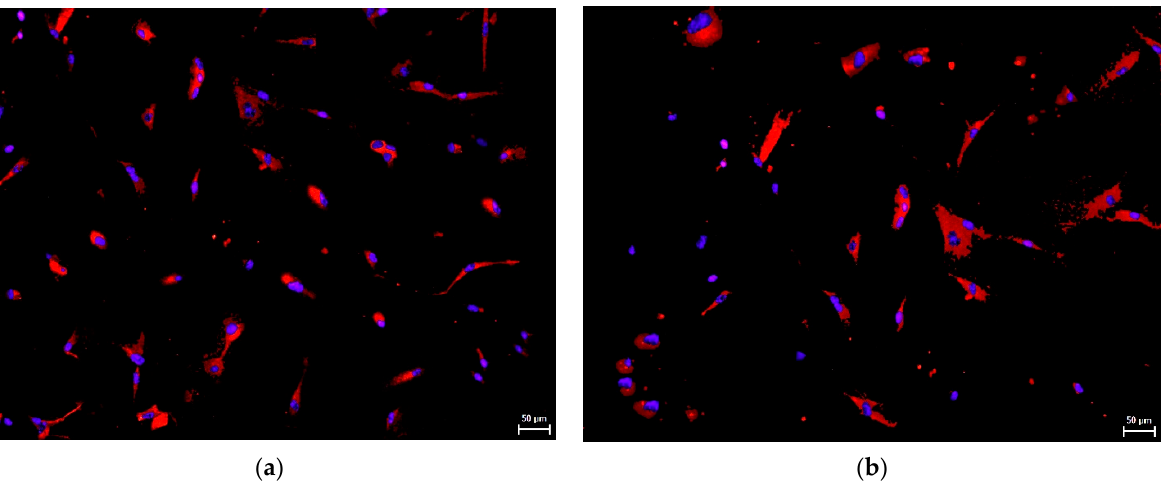
Figure 8. Immunocytochemical detection of Nanog, marker playing a role in ESC pluripotency, maintenance, and self-renewal, in undifferentiated hNDP-SCs harvested in the 7th passage. Most cells were positive for Nanog (red fluorescence). Cell nuclei fluorescent blue. Scale bare 50 μ m: ( a ) hNDP-SCs cultivated in the FBS-culture medium; ( b ) hNDP-SCs cultivated in the hPL-culture medium.